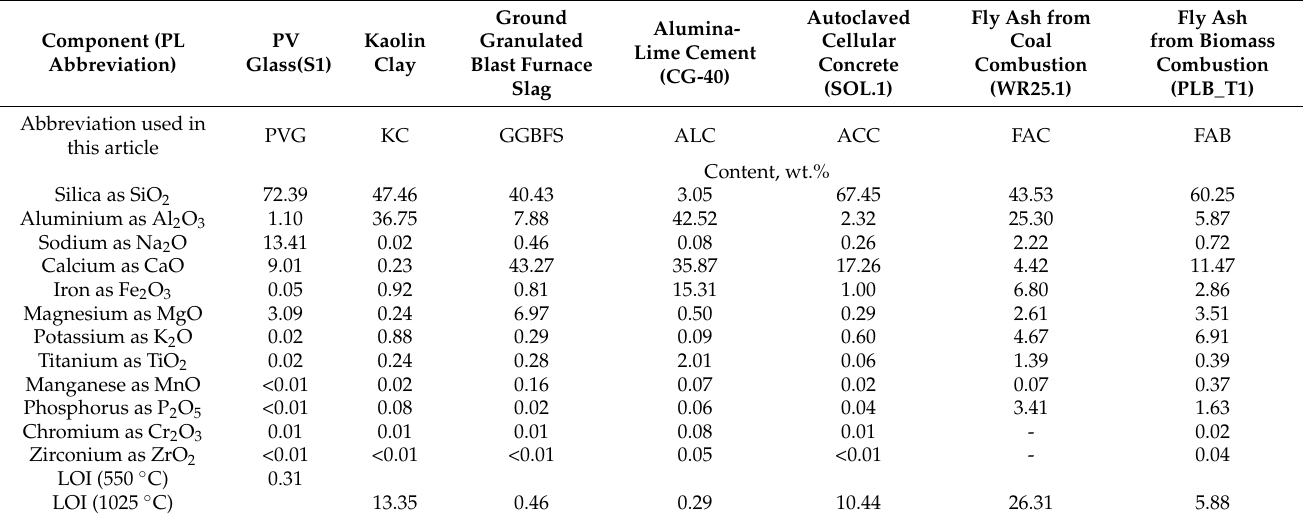
Table 1. Chemical composition of components for preparation of binder mixtures.